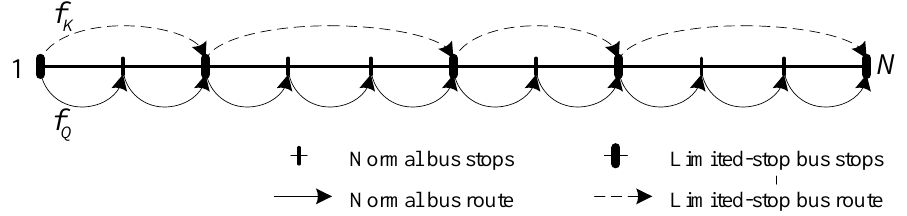
Figure 1. Organization of the mixed schedule of normal service and limited-stop service. The trip demand is assumed to be constant and known. The arrival of passengers at the bus stop is considered to be uniform. The waiting time that passengers are willing to bear is not long. The trip time for each passenger is assumed to be identical, and all buses drive at the same average speed. No bus is allowed to overtake and skip stops. The following section only shows the calculation of one direction, and the calculation of the other direction is